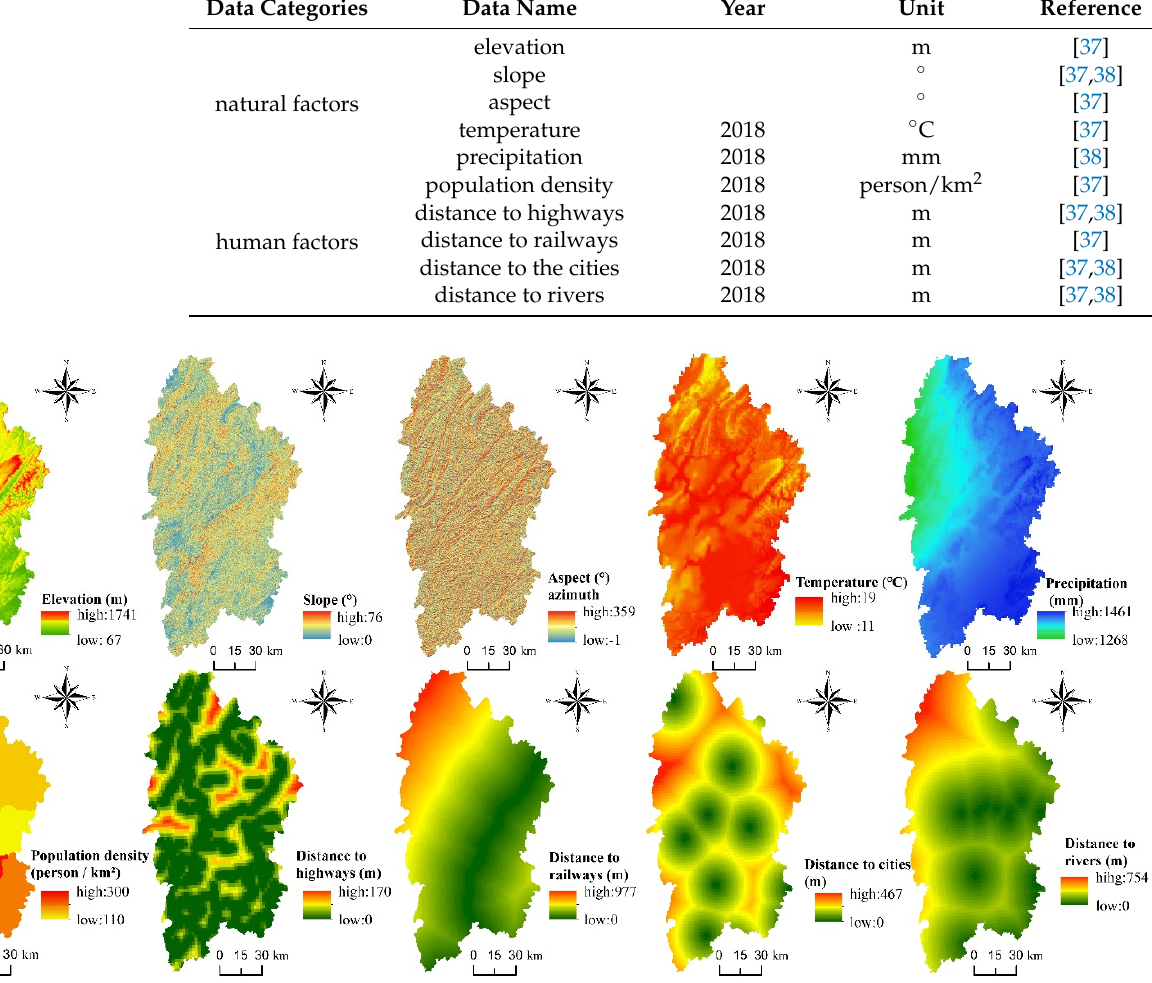
Table 2. Driving factors of agricultural land use change.